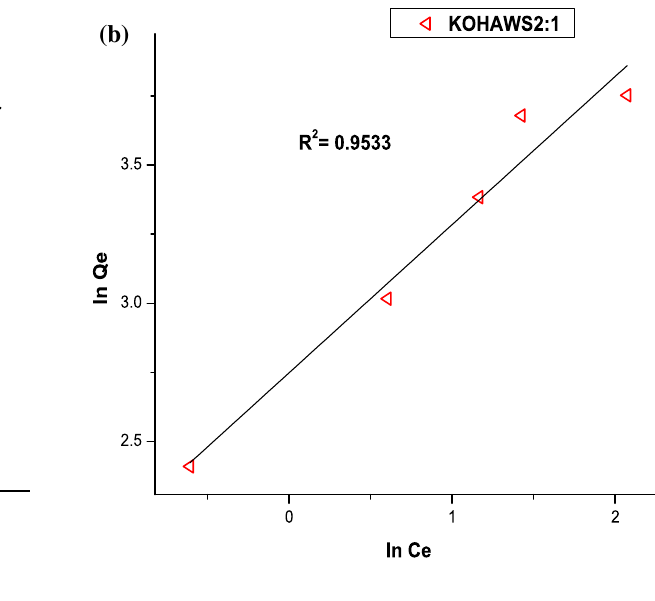
Fig. 12 Halsey isotherm for a KOHAWS1 and b KOHAWS2